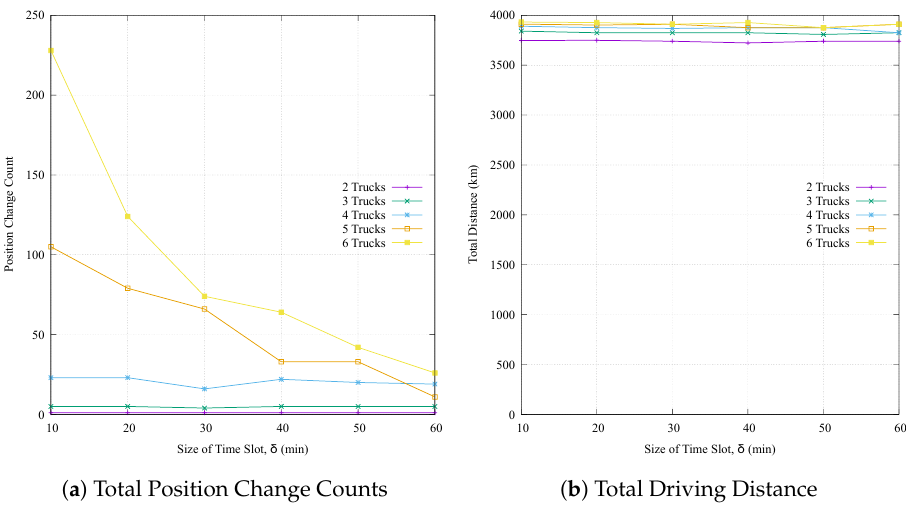
Figure 4. Performance of STS over Various Switching Period ( δ